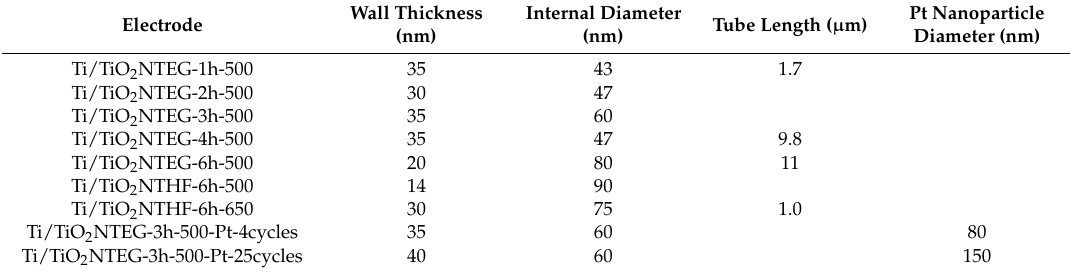
Table 2. Average wall thickness and internal diameters of nanotubes on the anodes evaluated by SEM imagines.